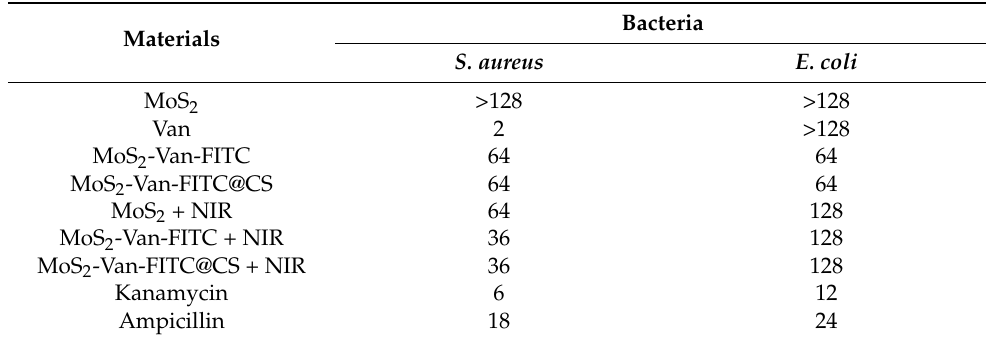
Table 1. Antibacterial activities with MICs values test ( µ g/mL).